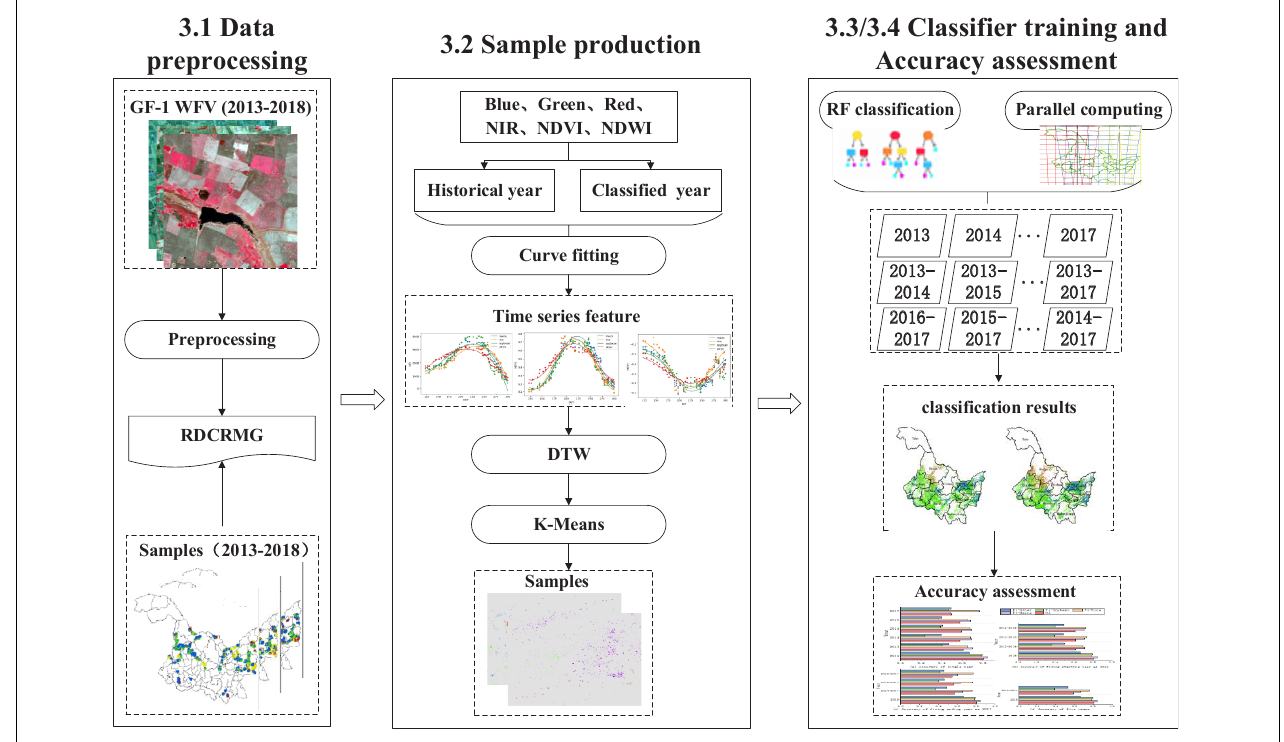
FIGURE 4 | Workflow of this